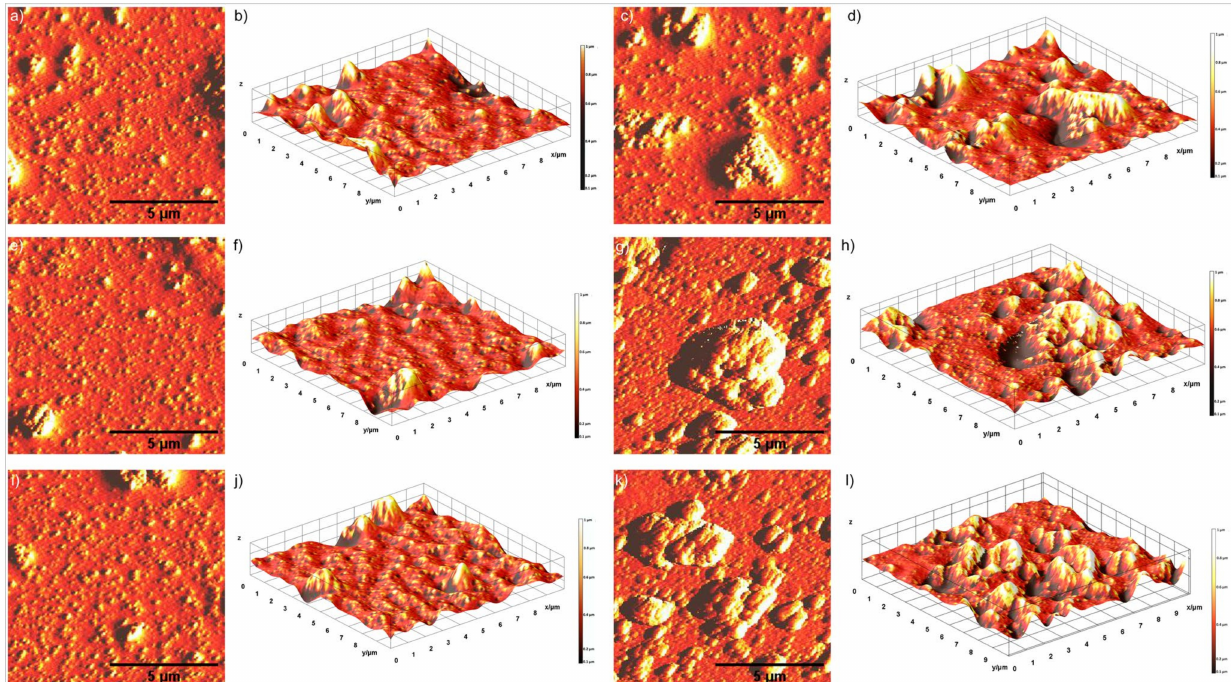
Figure 9. The 2D and 3D representations of the AFM surface topography of osteoblast cell development on Si after 24 h ( a , b ), 48 h ( e , f ), and 72 h ( i , j ) of incubation and on HApFe coatings after 24 h ( c , d ), 48 h ( g , h ), and 72 h ( k , l ) of incubation, collected across an area of 10 × 10 µ m 2